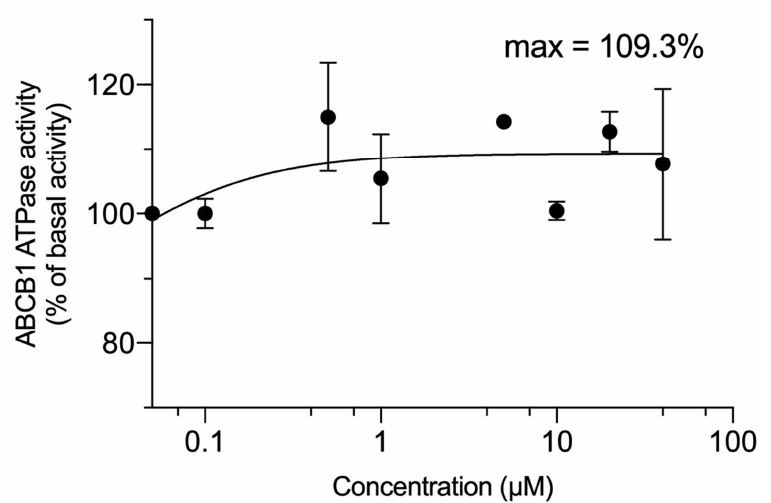
Figure 6. VKNG-2 stimulated the ATPase activity of ABCB1. The graph illustrates the effect of 0–100 µ M of VKNG-2 on the ATPase activity of ABCB1.